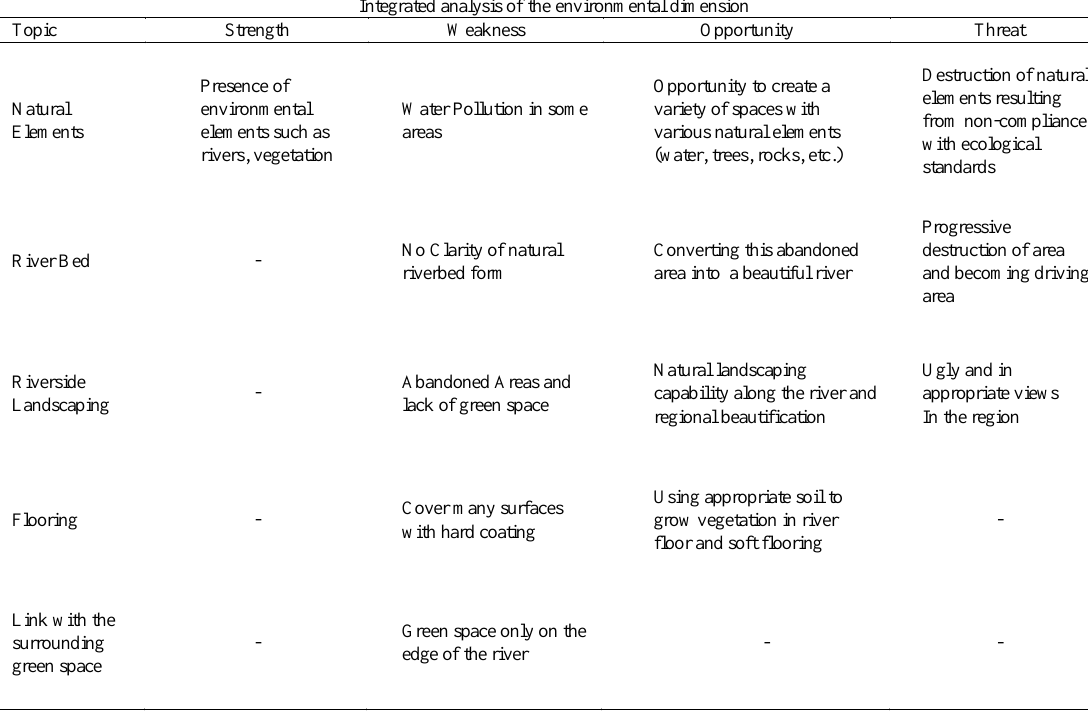
Table 1: Integrated analysis of the environmental dimension of the Khoshk River